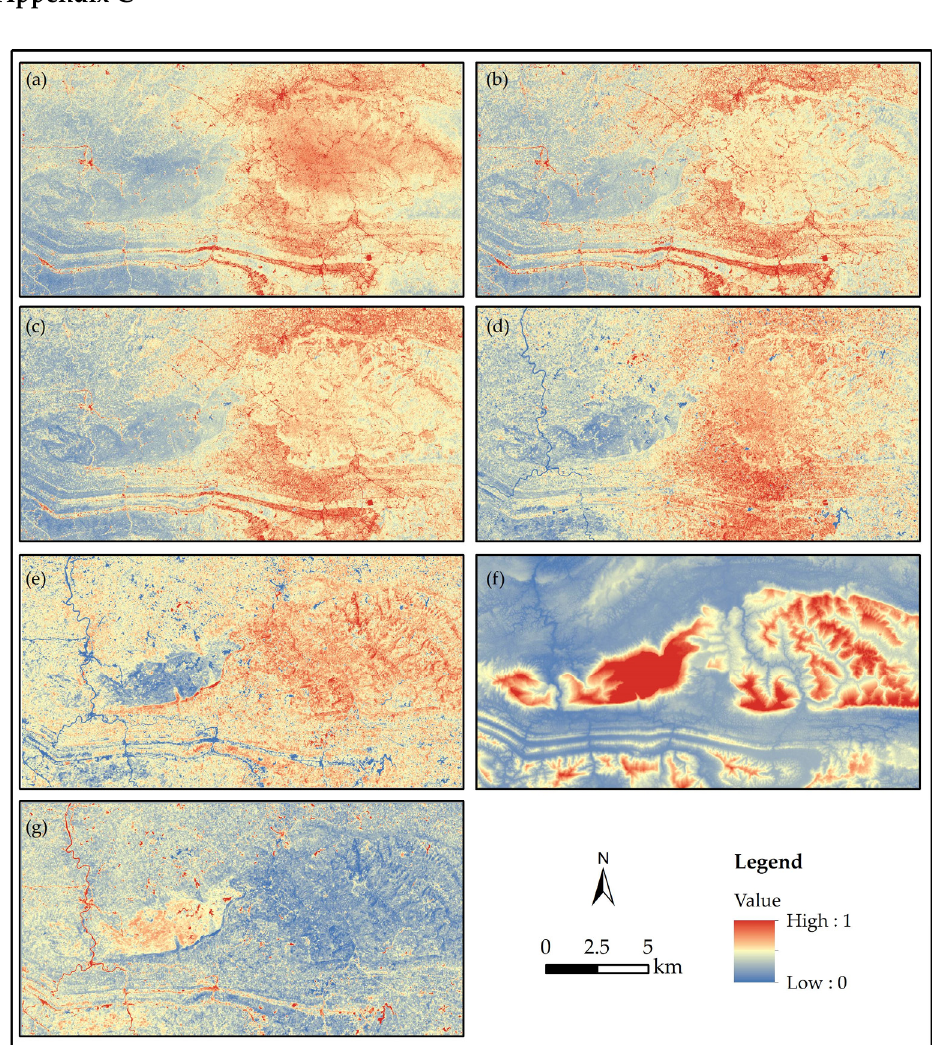
Figure A5. The optimal feature variables that were screened based on random forest and Spearman’s rank correlation analysis: ( a ) band 1, ( b ) band 4, ( c ) band 5, ( d ) band 17, ( e ) band 27, ( f ) elevation, and ( g ) mean. Note: All feature variables were normalized to 0–1.